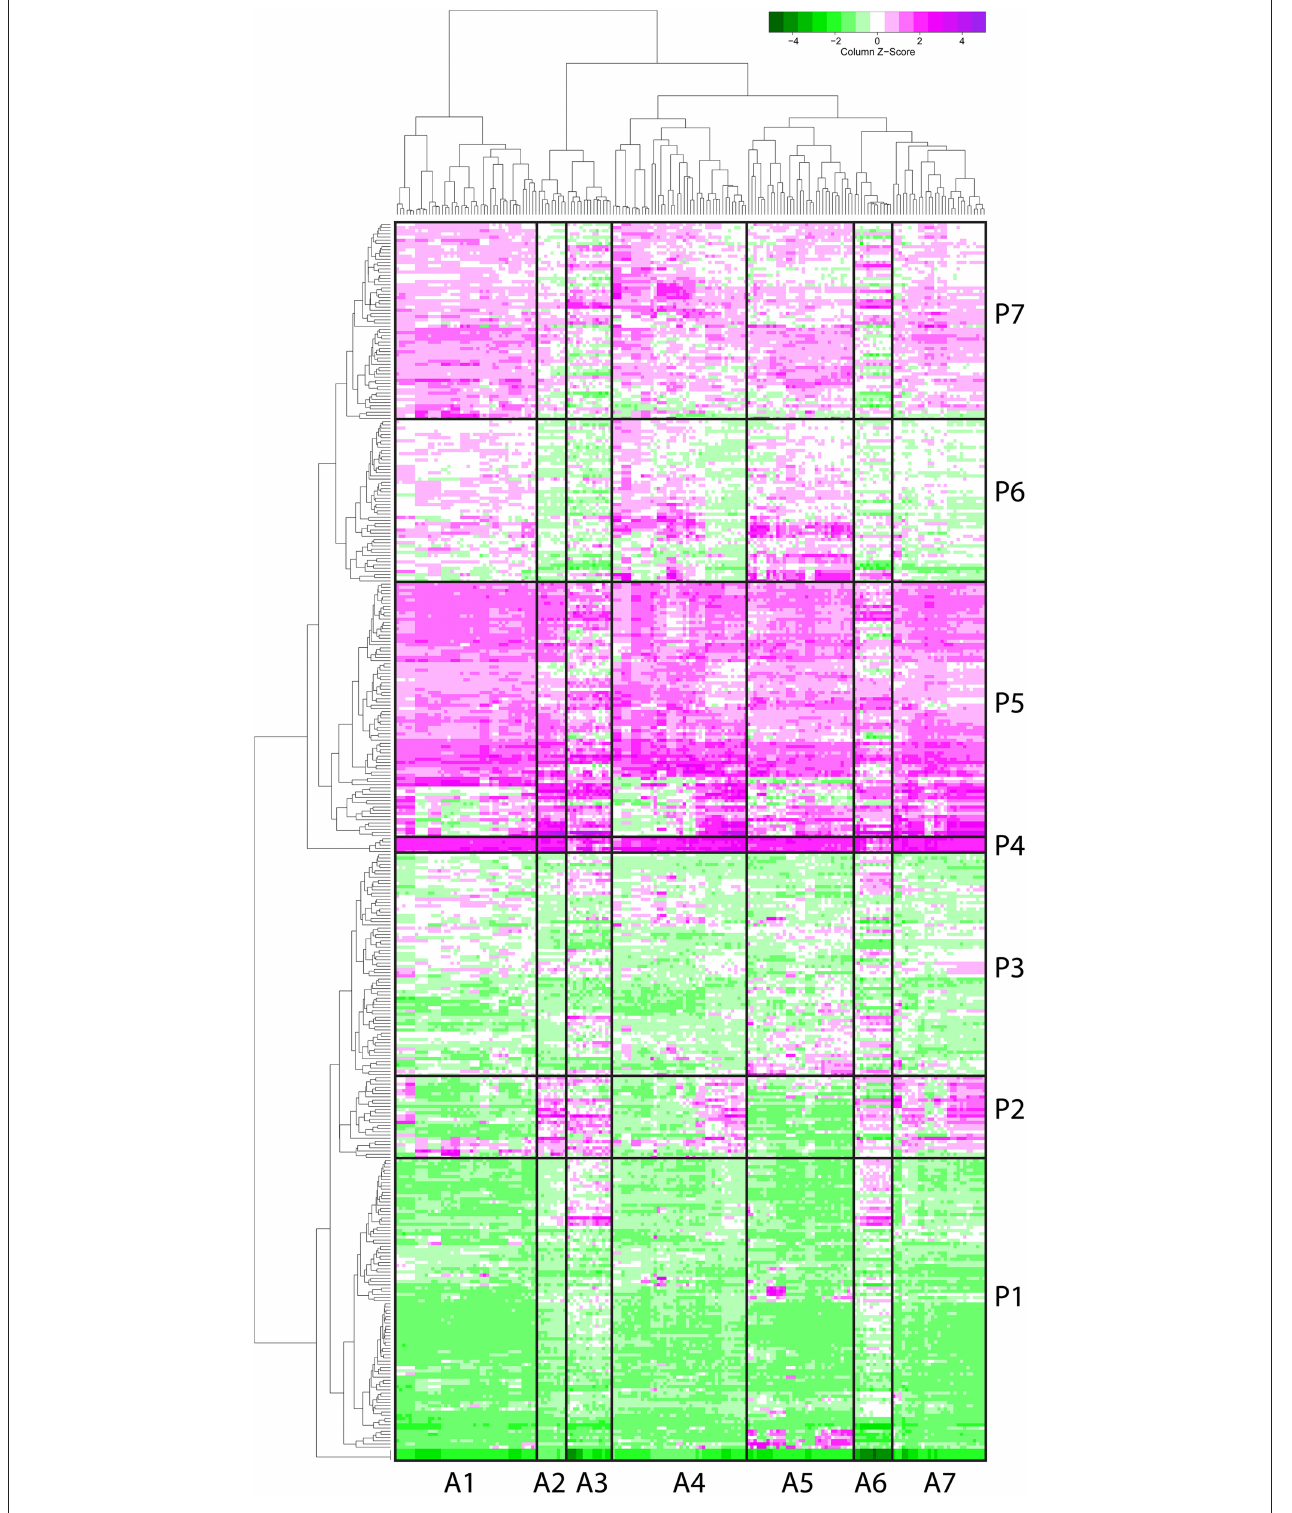
FIGURE 1 | Microarray heat map separates 389 peptidases into seven clusters based on their gene expression. Gene expression profiles of proteases (by microarray) were clustered and a heat map built (magenta for above average expression, green for below average expression). A protease dendrogram is shown on the y axis, and a microarray dendrogram on the x axis. Clusters were generated from the dendrogram with manual refinement to produce seven clusters of arrays (A1–A7) and seven clusters of peptidases (P1–P7).